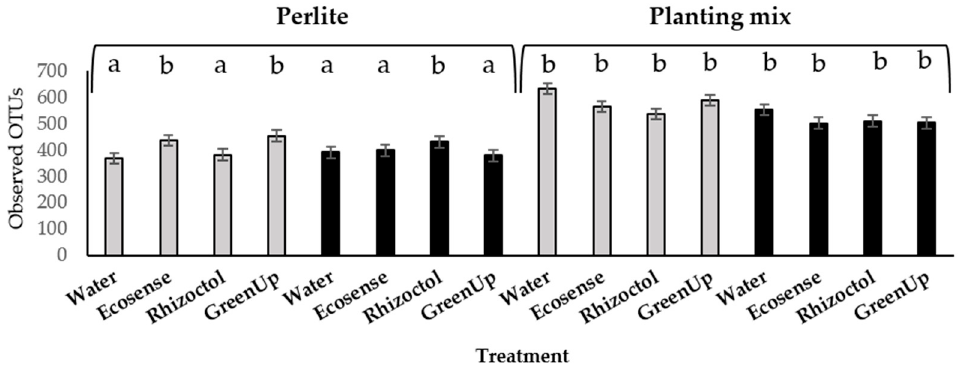
Figure 3. Mean operational taxonomic units (OTUs) per treatment, identified in the root-associated environments of Ornithogalum dubium and Zantedeschia aethiopica in two growth media. Columns represent mean numbers of OTUs in samples taken from three repetitions of each treatment of O. dubium (gray) and Z. aethiopica (black) grown in perlite or planting mix. Bars represent ± standard errors. Letters represent significantly different statistical groups.